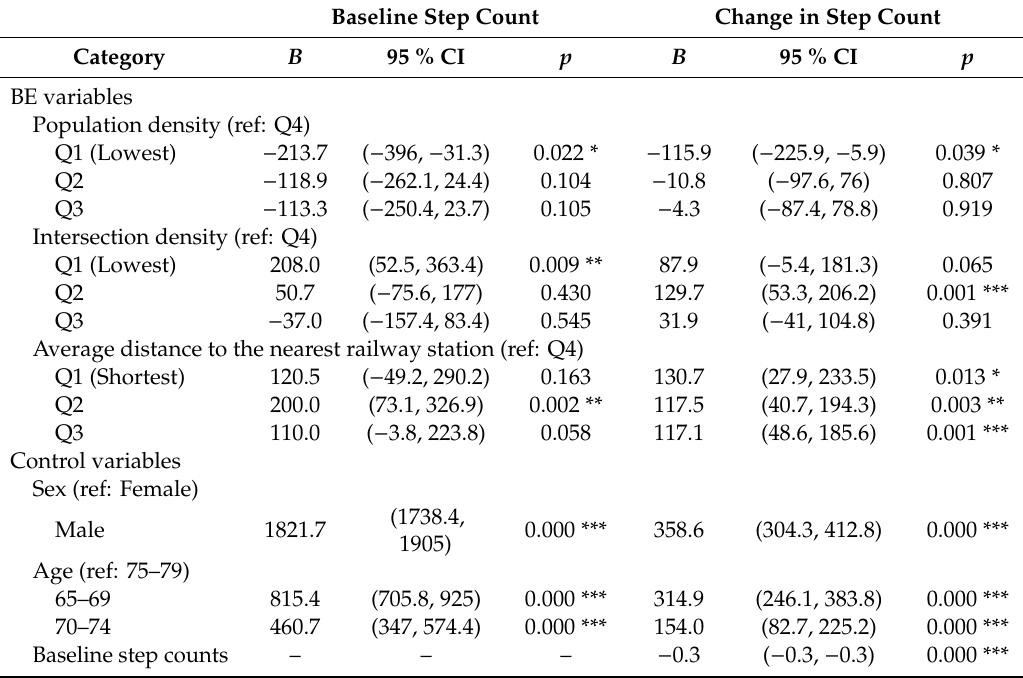
Table 3. Associations between BE variables and step count (baseline and change) using multilevel regression ( N =